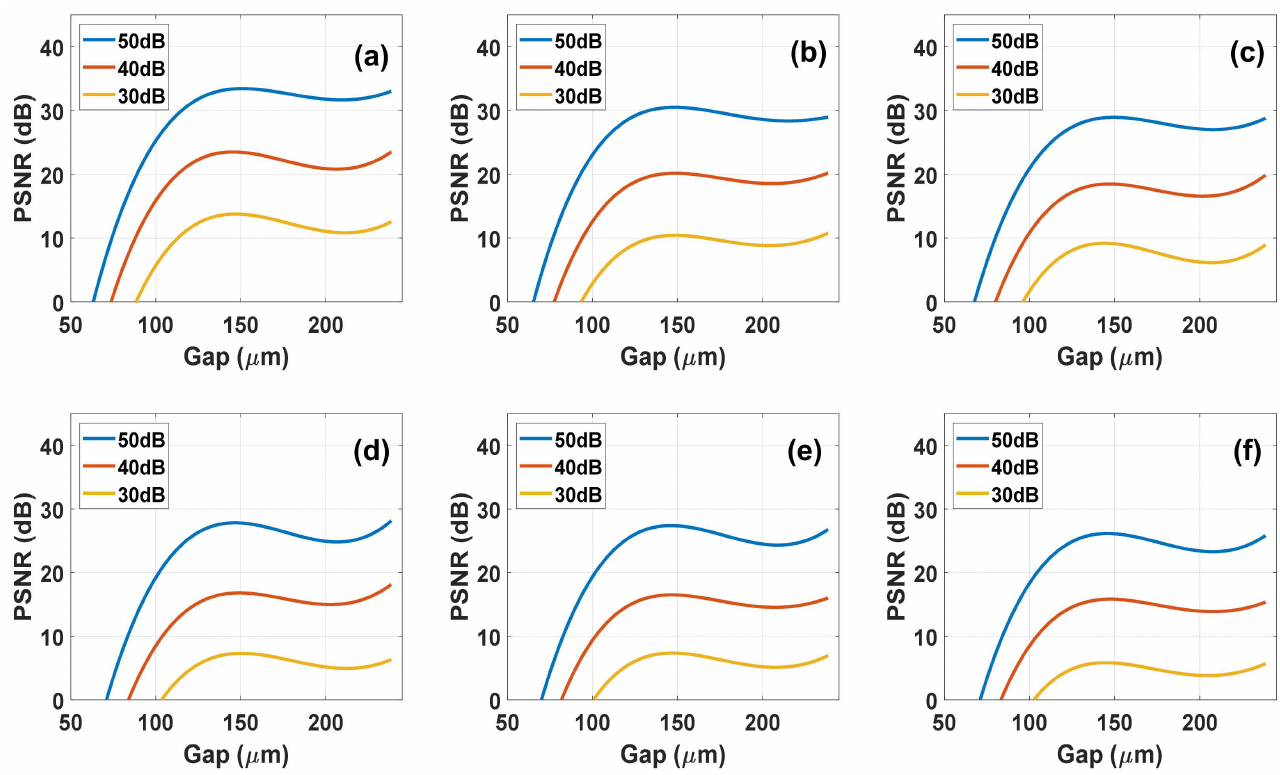
Figure 14. Simulation results of the reconstruction quality measured in PSNR, as function of the DHFLC cell gap at different SNR as indicated for each curve values and different number of voltages: ( a ) 151; ( b ) 76; ( c ) 51; ( d ) 38; ( e ) 31; ( f )